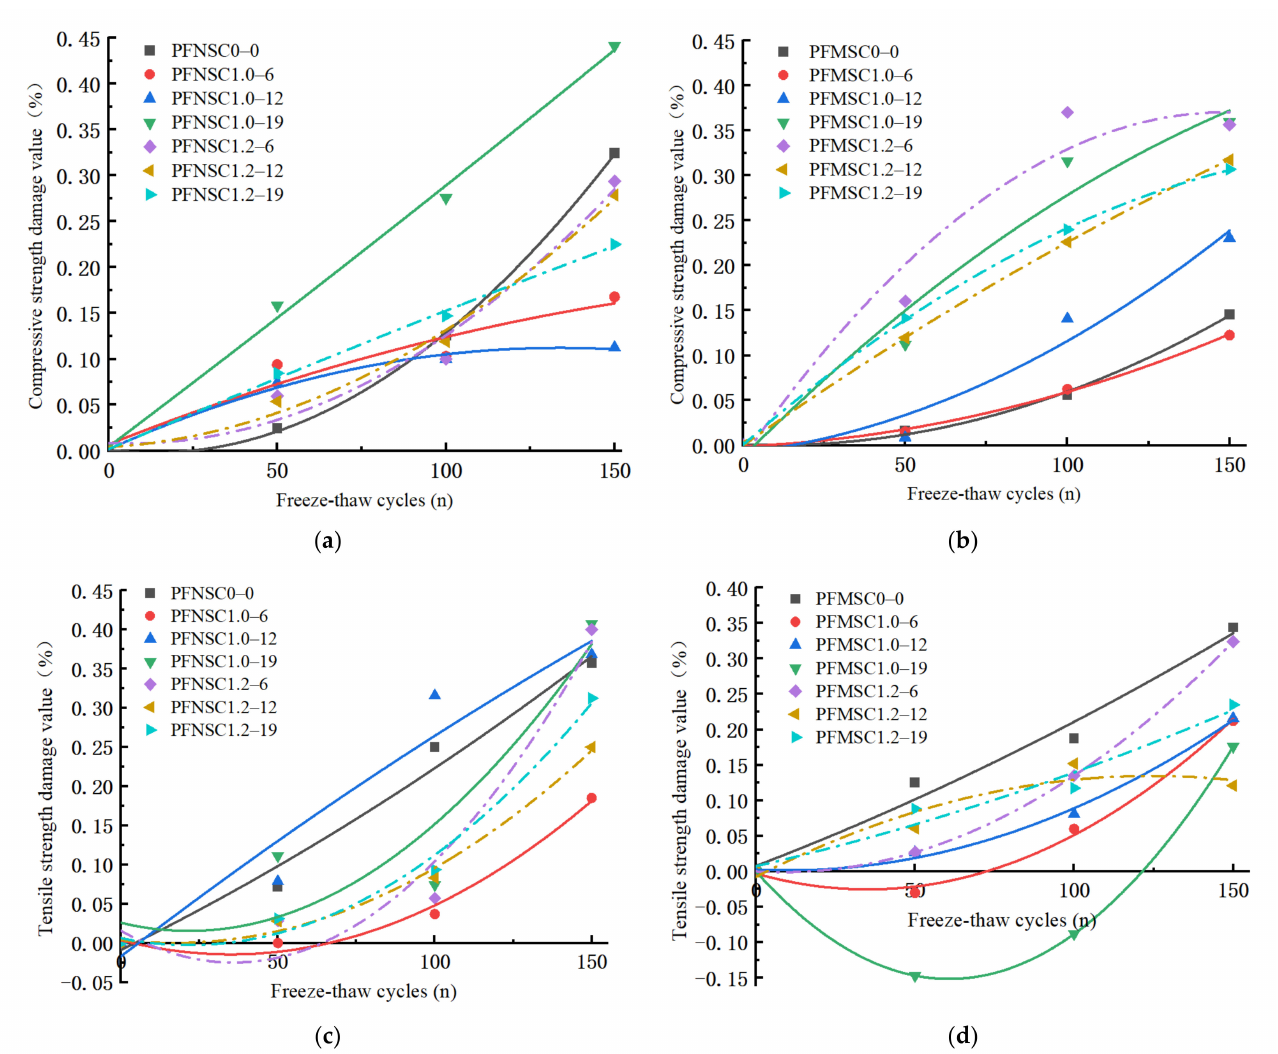
Figure 7. Strength damage under different freeze–thaw cycles: ( a ) PFNSC compressive strength damage rate, ( b ) PFMSC compressive strength damage rate, ( c ) PFNSC splitting tensile strength damage rate, ( d ) PFMSC splitting tensile strength damage